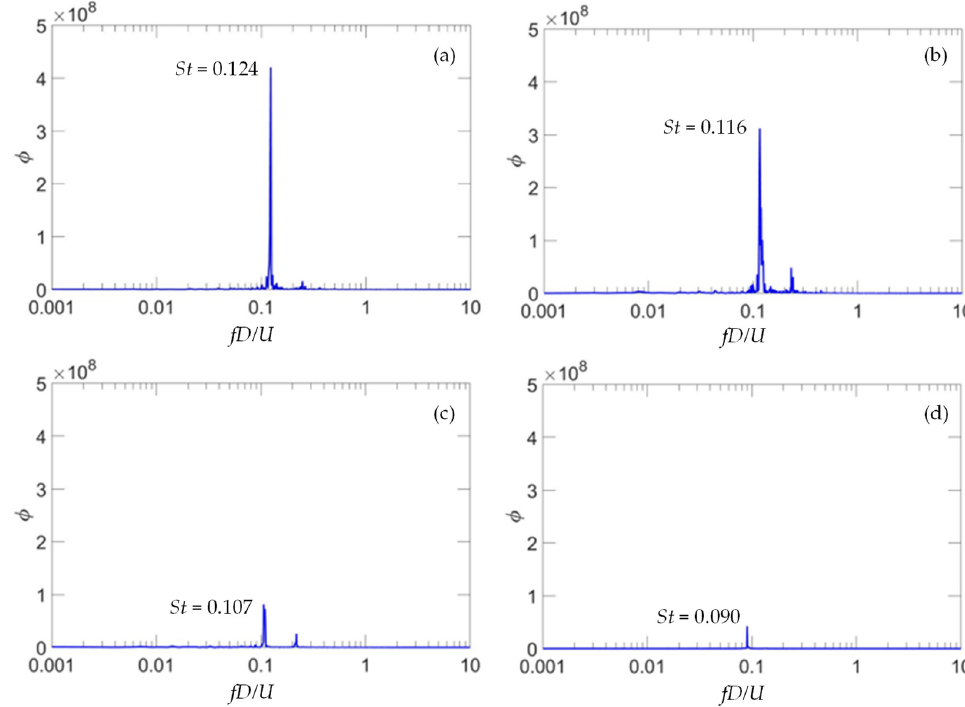
Figure 6. Energy spectra of the lift coefficient for different cylinder yaw angles. ( a ) α = 0°; ( b ) α = 15°; ( c ) α = 30°; ( d ) α = 45°.